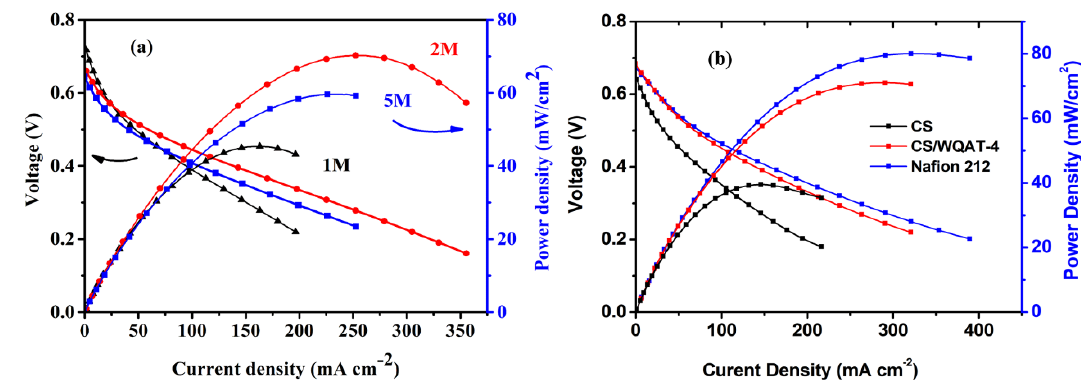
Figure 8. Polarization and power density curves of DMFC tests of ( a ) the CS/WQAT ‐ 4 composite membrane at different methanol concentrations, and ( b ) different PEMs at 70 °C with a 2 M methanol solution as the anode fuel.